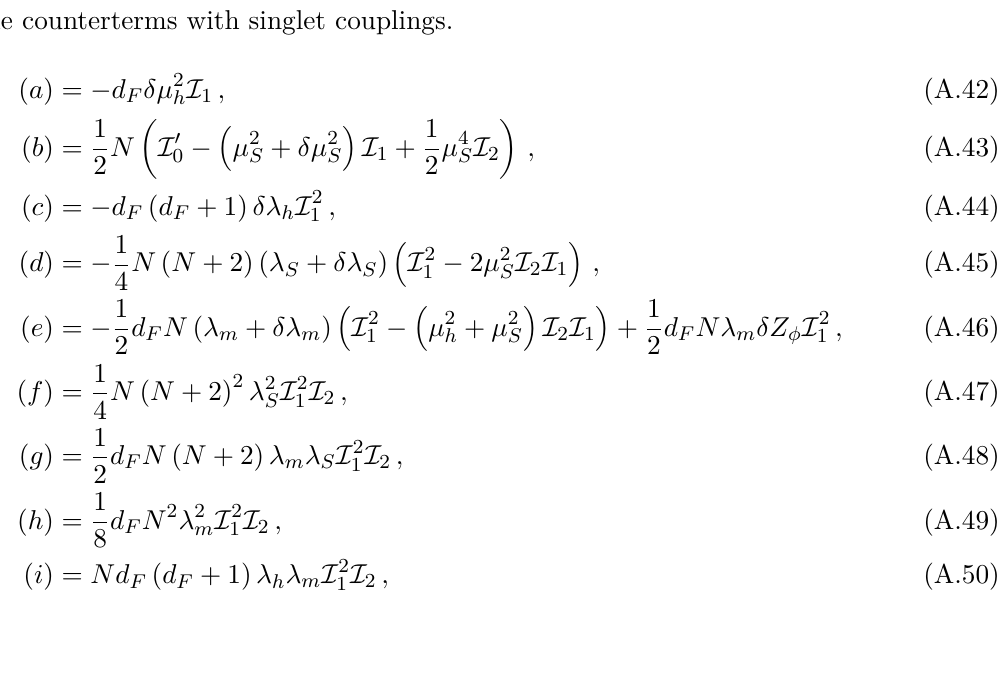
Vacuum Feynman diagrams at the hard scale with the